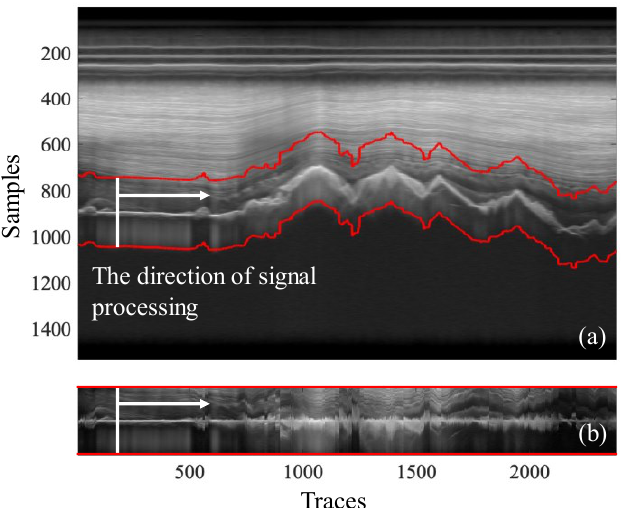
Figure 4. ( a ) B-scope radargram profile after the operation of along-track smoothing, where the red lines represent the location of 150 sampling points above and below the true basal interface. ( b ) B-scope radargram profile after the banding operation.